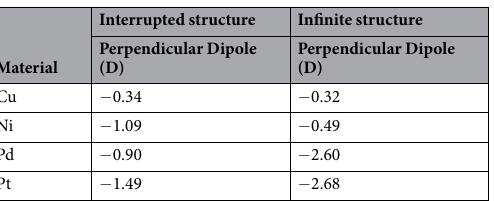
Table 1. Perpendicular dipole moment for the interrupted and extended configurations of the systems under consideration (1 Debye = 3.336 × 10 − 30 C ·